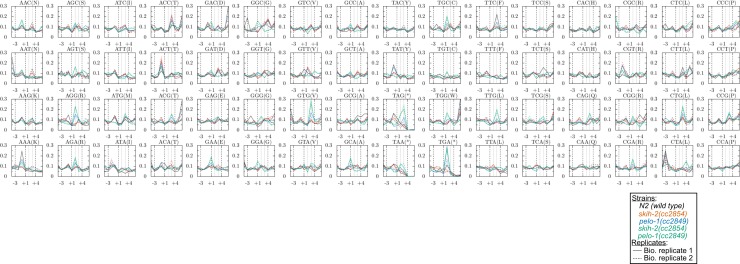
Metacodon plot of 3’end locations for all codons.See Figure 5 for description.